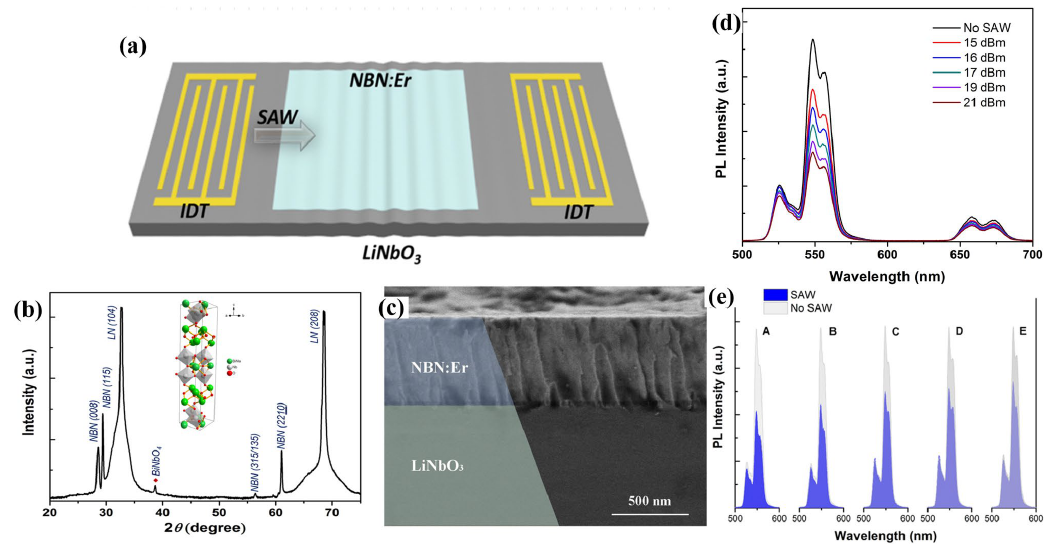
Figure 10. ( a ) Device structure diagram. ( b ) XRD of NBN: Er/LN. ( c ) FE-SEM image of cross-section of NBN: Er/LN sample. ( d ) Time-integrated PL spectra of the NBN: Er film with and without SAW of different powers under 980 nm laser excitation. ( e ) PL spectra of five points along the acoustic pathway with and without SAW modulation. Reprinted with permission from [58] 2020 Wiley-VCH.